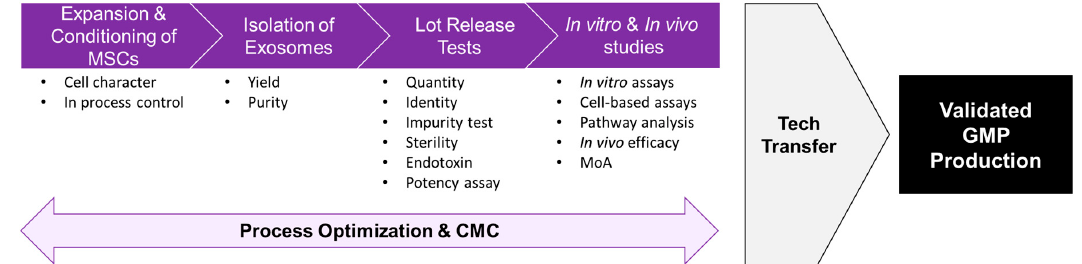
Figure 7. Schematic diagram of process development for exosome-based therapeutics.